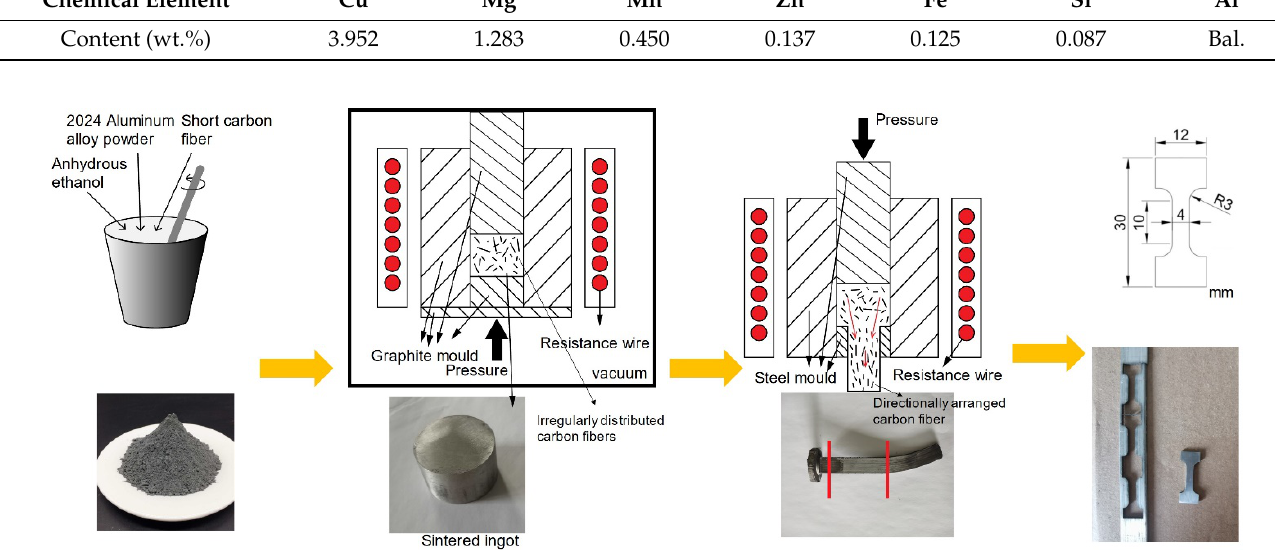
Figure 1. Experimental flow diagram. Table 1. Chemical composition of the as-received 2024 Al powder (wt.%).